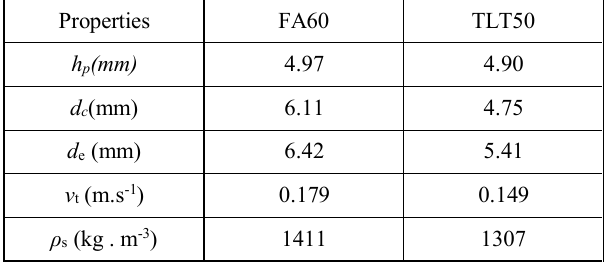
Table 1. Properties of experimental bed-load particles